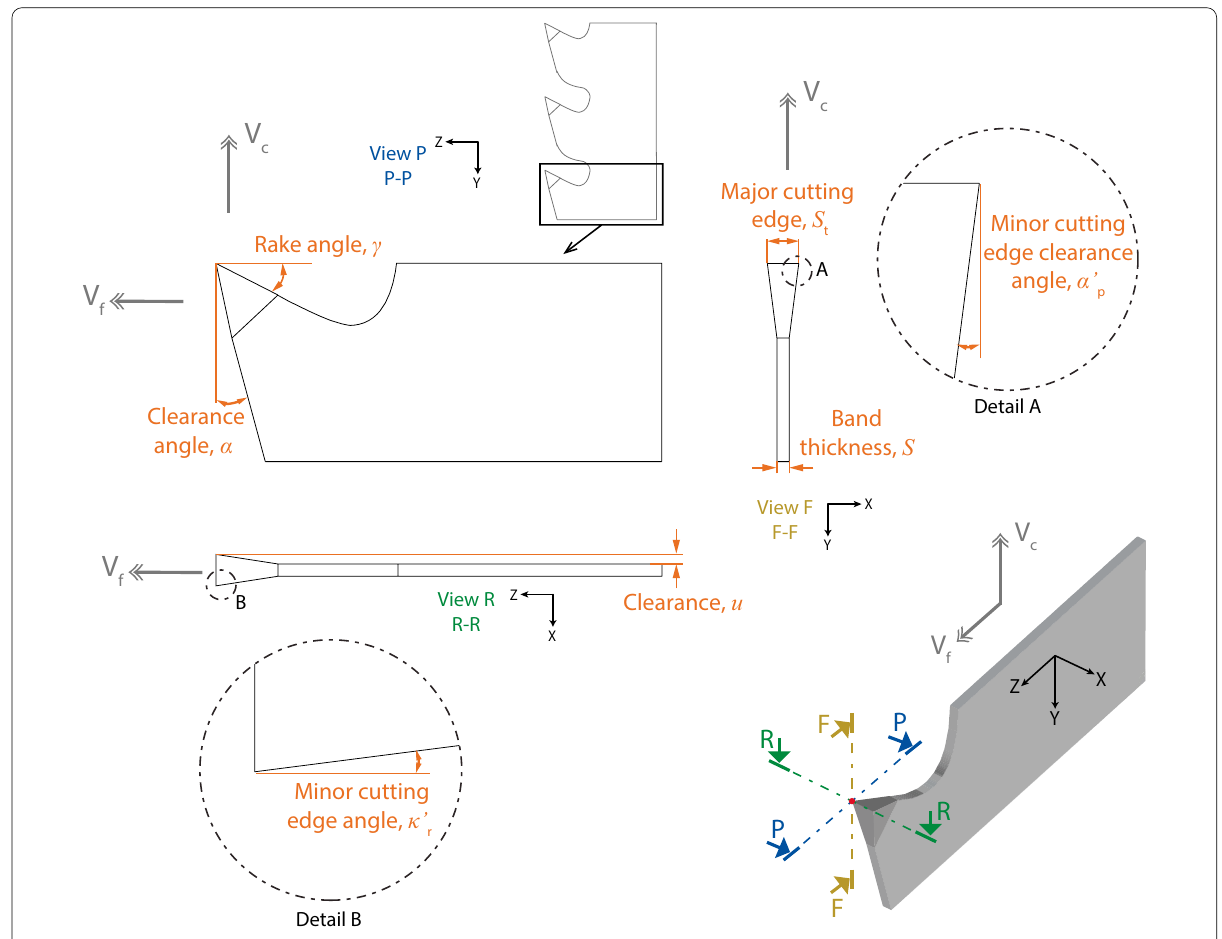
Fig. 1 Geometry of a single cutting tooth used in wood sawing according to ISO 3002:1